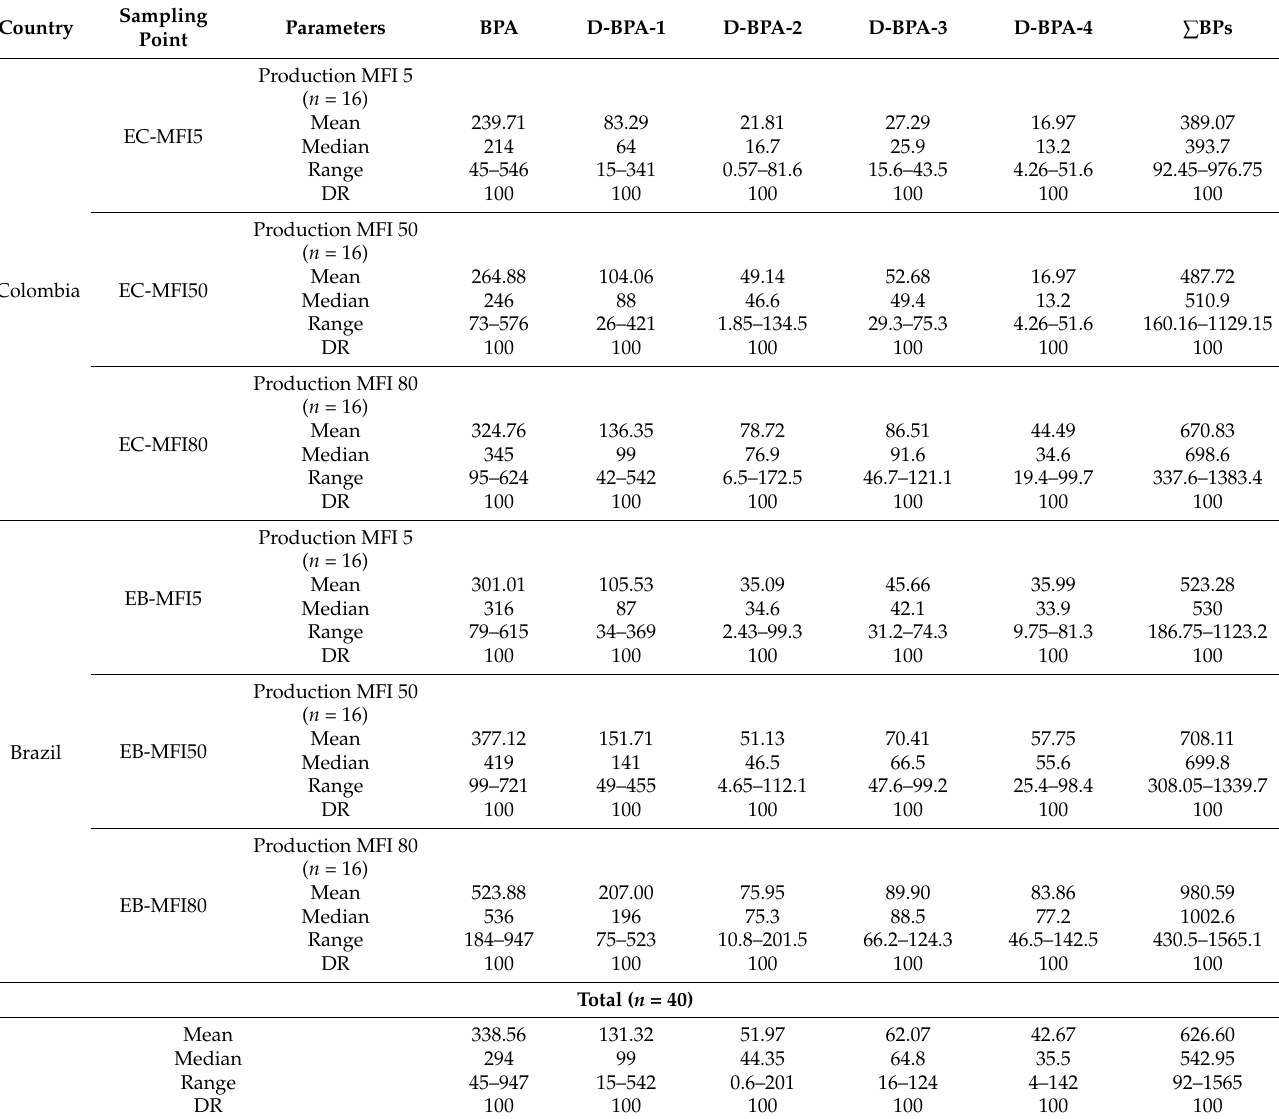
Table 1. Concentrations of bisphenol analogues (ng g − 1 dry weight) in atmospheric emissions from PP production plants in Colombia and